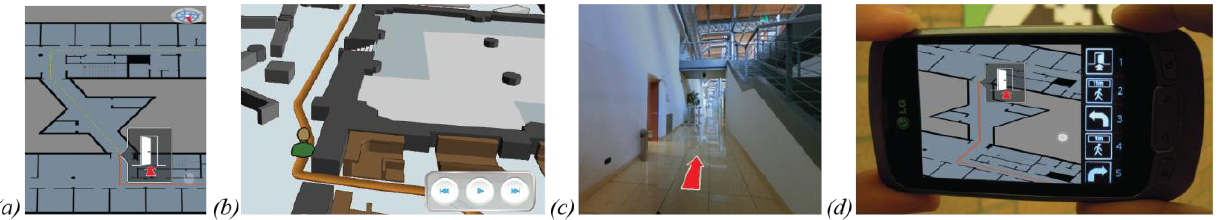
Figure 3. Communicating the route through: a 2D map ( a ); a perspective view of a 3D map ( b ); information in augmented reality ( c ); and a list of step by step instructions ( d